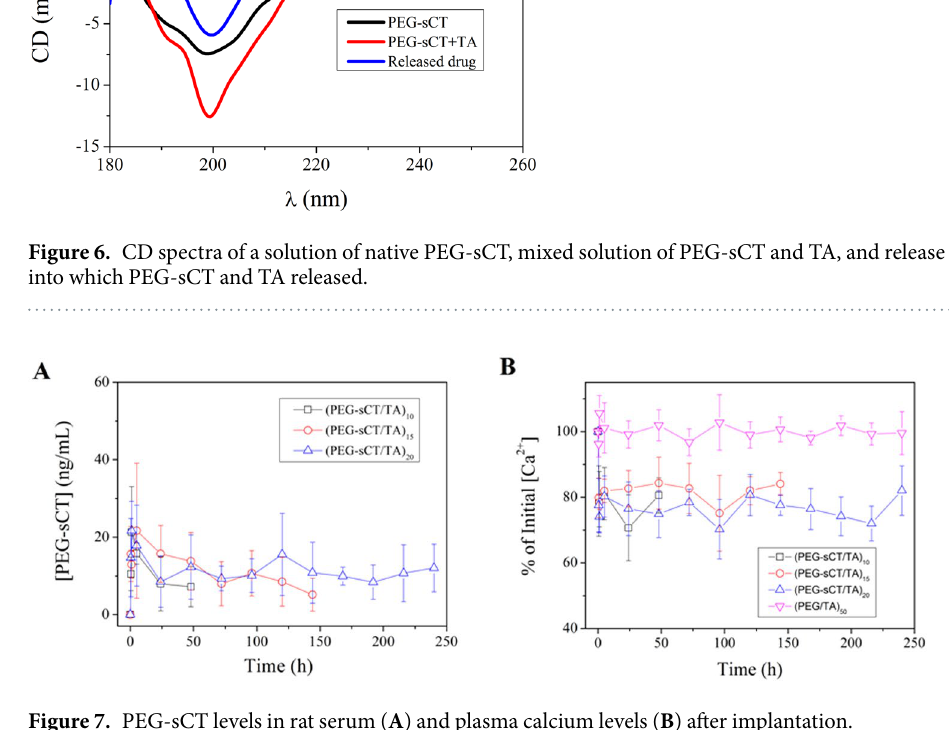
Figure 7. PEG-sCT levels in rat serum ( A ) and plasma calcium levels ( B ) after